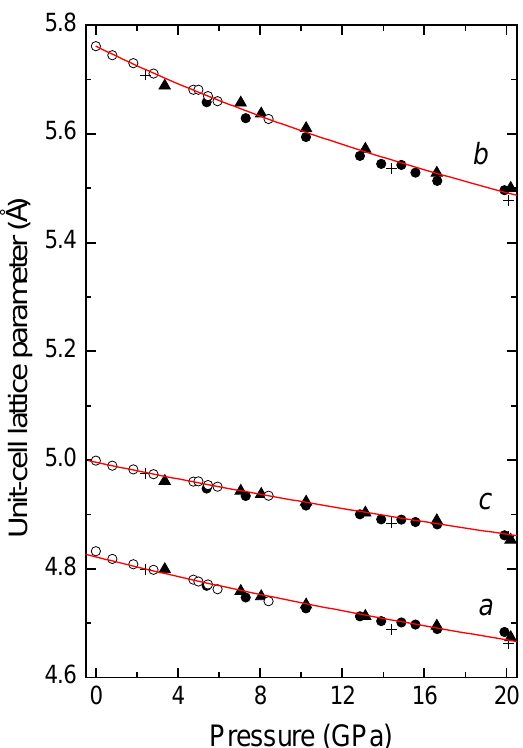
Figure 2. Pressure dependence of the unit-cell lattice parameters of MnWO 4 . Empty circles represent Macavei’s and Schulz’s data [10], full circles and triangles represent data obtained by powder X-ray diffraction, and the crosses represent data obtained by single crystal X-ray diffraction [14]. The continuous lines are fits to a third-order Birch–Murnaghan equation of state.